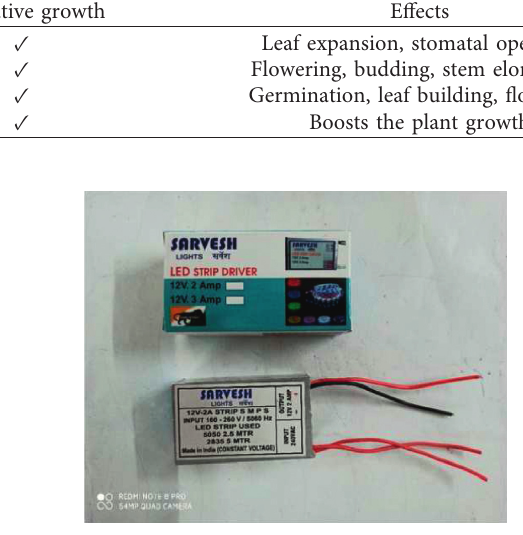
Figure 8: 12V/2 A driver.